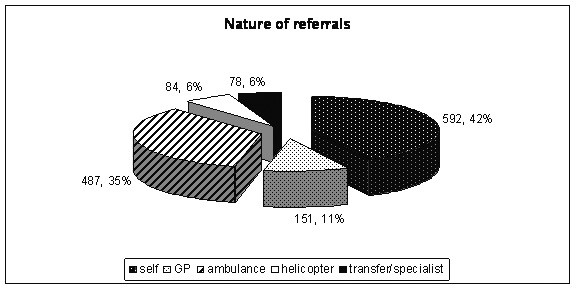
Nature of referrals.